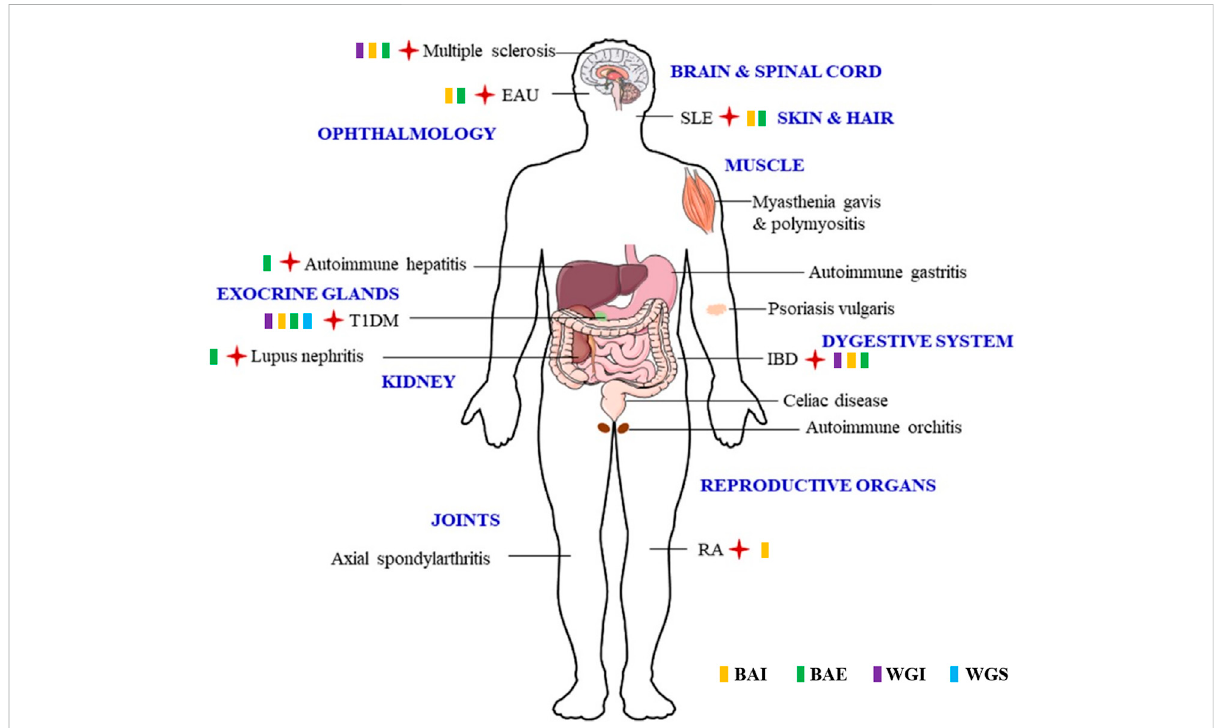
FIGURE 3 The veri fi ed ADS affected by SBG and its fl avonoids are highlighted by red cross, and the effective fl avonoid is marked by relevant